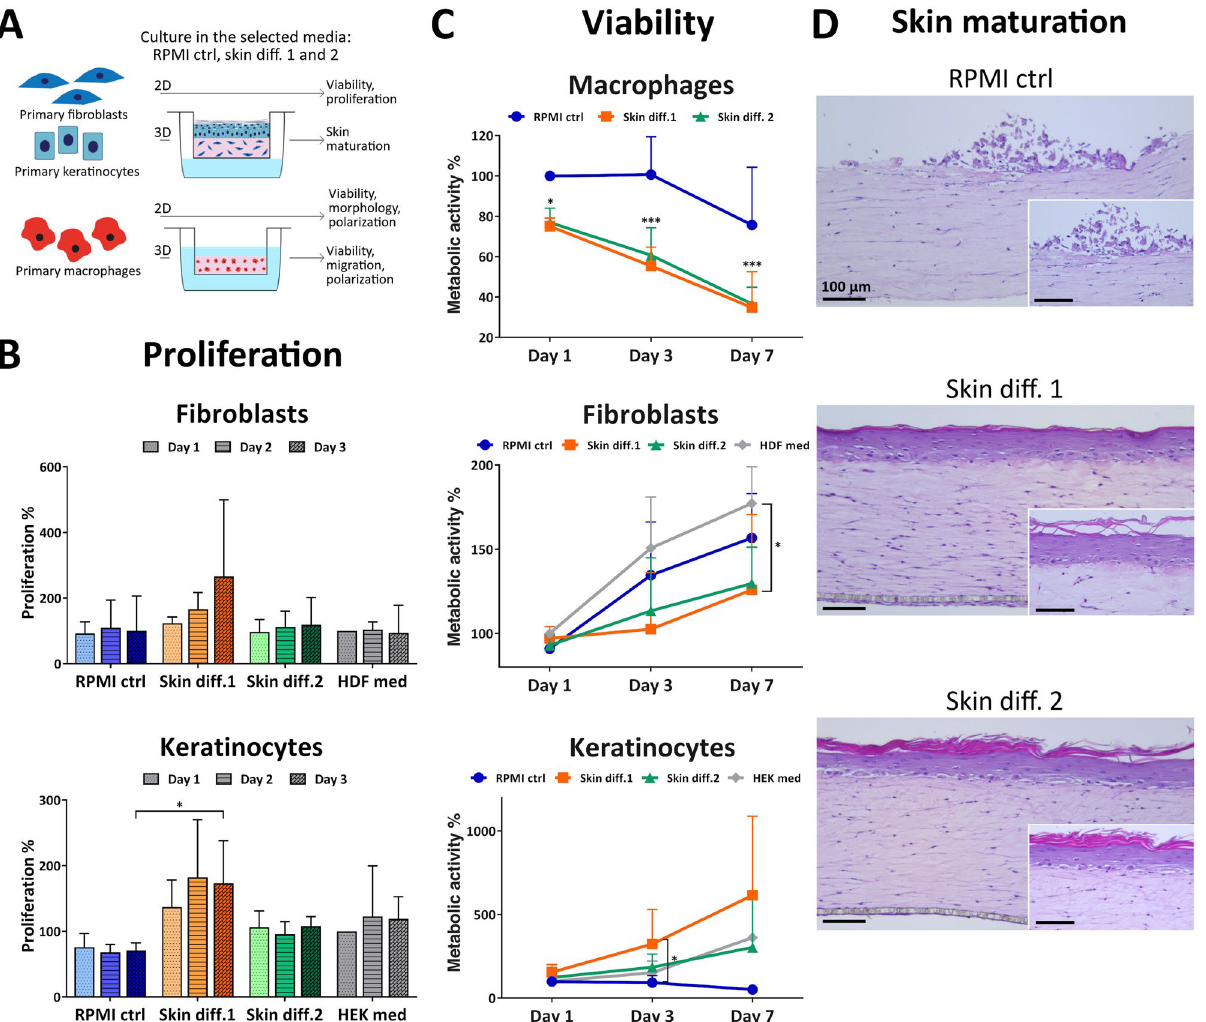
Figure 1. Influence of culture medium composition on skin cell viability and proliferation and in vitro skin maturation. ( A ) Schematic of the experiments performed. ( B ) Proliferation and ( C ) viability of primary fibroblasts, keratinocytes and macrophages cultured in RPMI control (“RPMI ctrl”), skin differentiation 1 (“Skin diff. 1”) or skin differentiation 2 (“Skin diff. 2”) media. Values are normalized to fibroblasts, keratinocytes or macrophages cultured for 1 day in fibroblast (“HDF med”), keratinocyte (“HEK med”) or RPMI control medium, respectively. N = 3, triplicate measurements for fibroblasts and keratinocytes; N = 5, triplicate measurements for macrophages. Error bars represent standard deviation (two-way ANOVA, Tukey’s multiple comparisons test). Statistical significance indicated with * p < 0.05, *** p < 0.001. ( D ) Representative histological images of skin models cultured in the three media after 7 days of air-lift culture. N = 3, triplicate measurements. Scale bars: 100